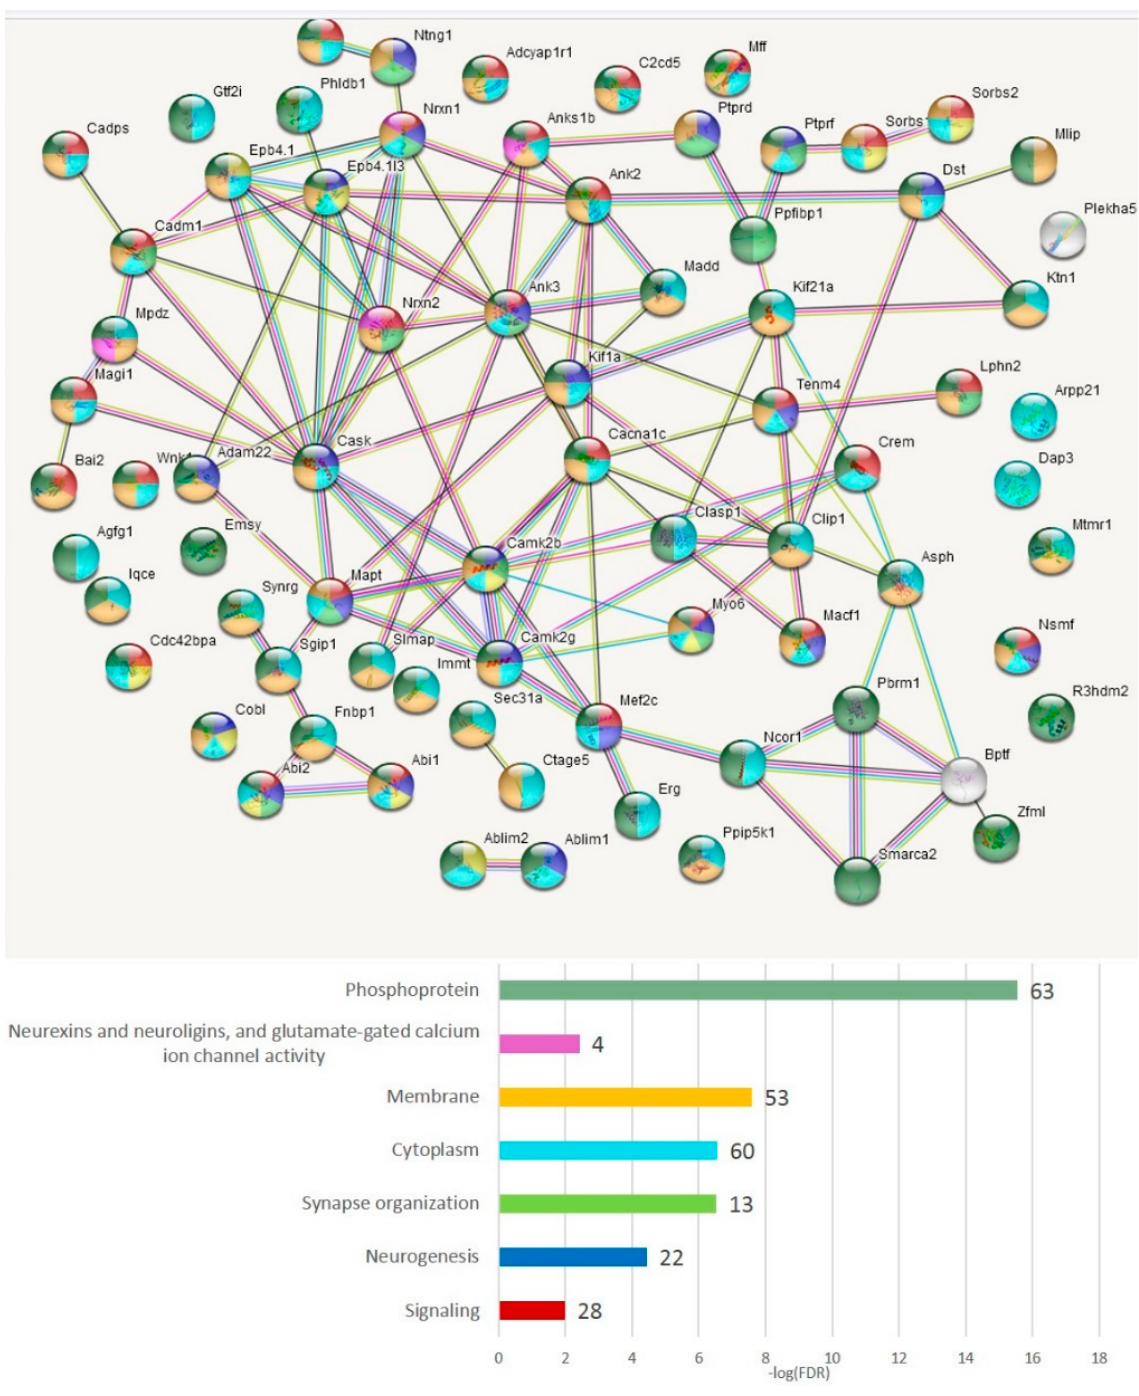
Figure 18. String-db.org connectome emphasizes that the AS2 (coding) ES abundant genes (75 entries; Table S6e) are highly interconnected (PPI enrichment, FDR < 1 × 10 − 16 ), and non-randomly express specifically in membrane/cytoplasmic compartments. Full GO annotation is available in Table S6f. An expanded network version of the figure can be found in Table S6f.